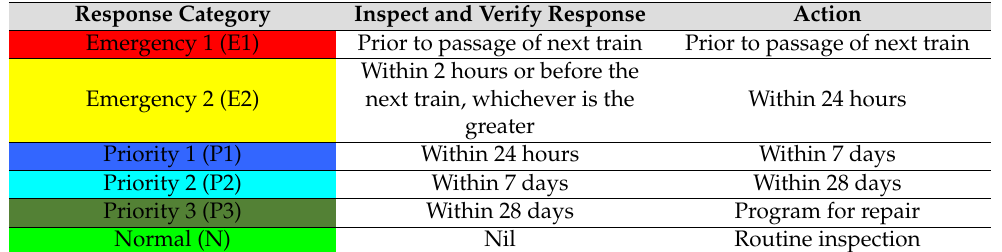
Table 3. Repair requirements for six standard defect